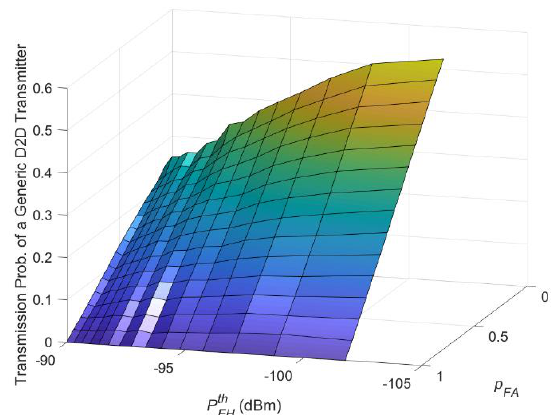
Figure 14. The D2D transmission probability ( 𝑝 𝑡D2D ) vs. the probability of false alarm (i.e., 𝑝 𝐹𝐴 ) and the predetermined energy harvesting (EH) threshold (i.e., 𝑃 𝐸𝐻𝑡ℎ ) of the cognitive D2D transmitters. The effect of the predefined EH threshold 𝑃 𝐸𝐻𝑡ℎ on the D2D transmission probability is depicted in Figure 14. The larger the value of 𝑃 𝐸𝐻𝑡ℎ , the lower the D2D transmission probability. This is because the probability that a D2D transmitter harvests sufficient energy (i.e., 𝑝 𝑠D2D ) decreases as 𝑃 𝐸𝐻𝑡ℎ increases (see Equation (34)), and as a result, we will observe a lower D2D transmission probability (see Equation (31)). We also observe the relationship between p D2D , the predefined sensing threshold γ , and the EH threshold P th in Figure 15. Clearly, a higher D2D transmission probability can be achieved for the larger values of 𝛾 and smaller values of 𝑃 𝐸𝐻𝑡ℎ .